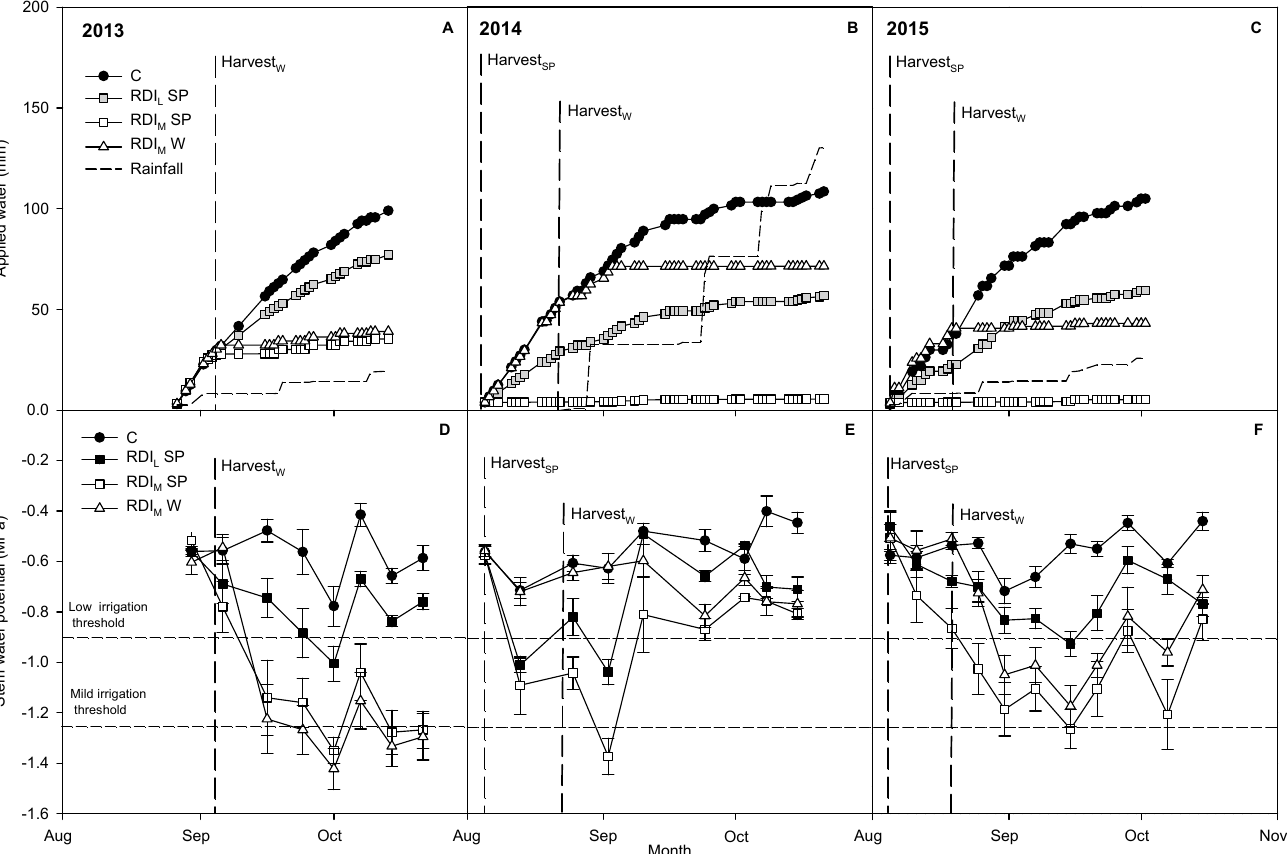
Figure 1. Amount of applied water and rainfall corresponding to the different irrigation treatments during 2013 ( A ), 2014 ( B ) and 2015 ( C ). Seasonal variation in midday stem water potential ( Ψ stem ) in response to different irrigation treatments during 2013 ( D ), 2014 ( E ) and 2015 ( F ). Irrigation treatments were C, control; RDI L SP, low regulated deficit irrigation for sparkling base wine production; RDI M SP, mild regulated deficit irrigation for sparkling base wine production; and RDI M W, mild regulated deficit irrigation for wine production. Stem water potential values are the mean values of the treatments, and bars indicate the standard error for eight leaves. Harvest SP and Harvest W indicate harvest time for sparkling base wine and wine criteria, respectively.